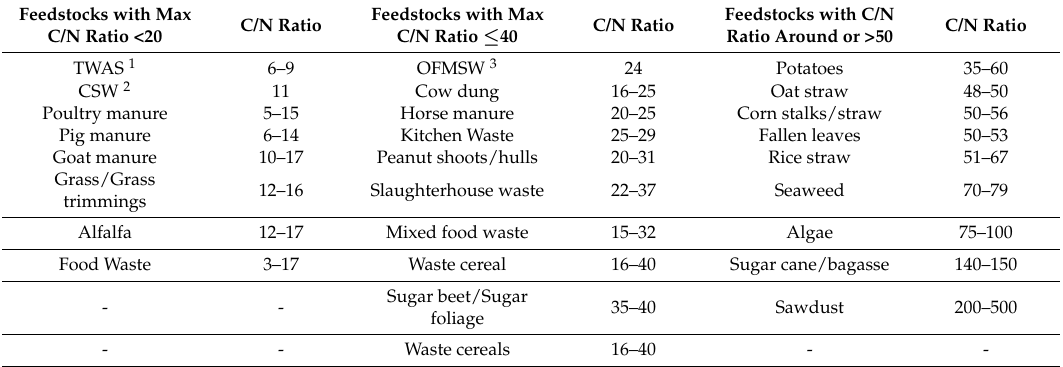
Table 1. Potential feedstocks for co-digestion to balance nutrient with regard to C/N ratio [26,50–52]. Feedstocks with Max C/N C/N Ratio <20